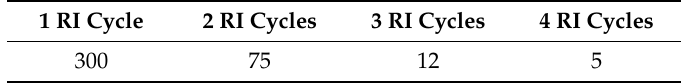
Table 3. Number of storms that have undergone 1, 2, 3, and 4 RI cycles during their lifetime.